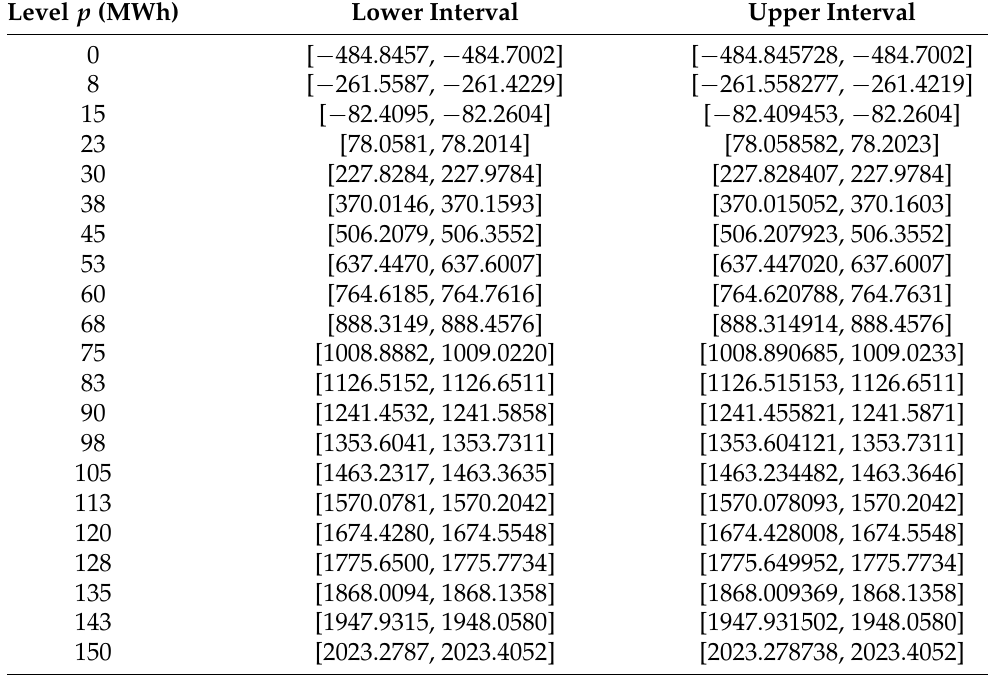
Table 2. Solution diagnostics based on 50 trajectories (with η 1 = 100 and η 2 = 15) and ψ 0 = 10.